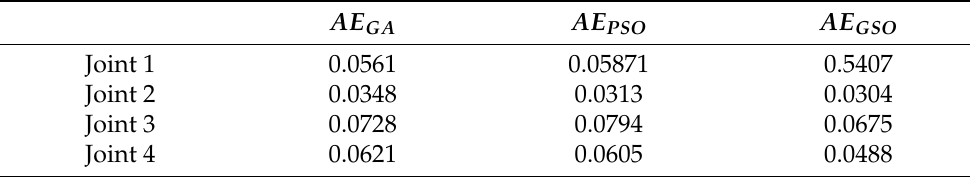
Table 7. Angular trajectory average error for optimal tuned